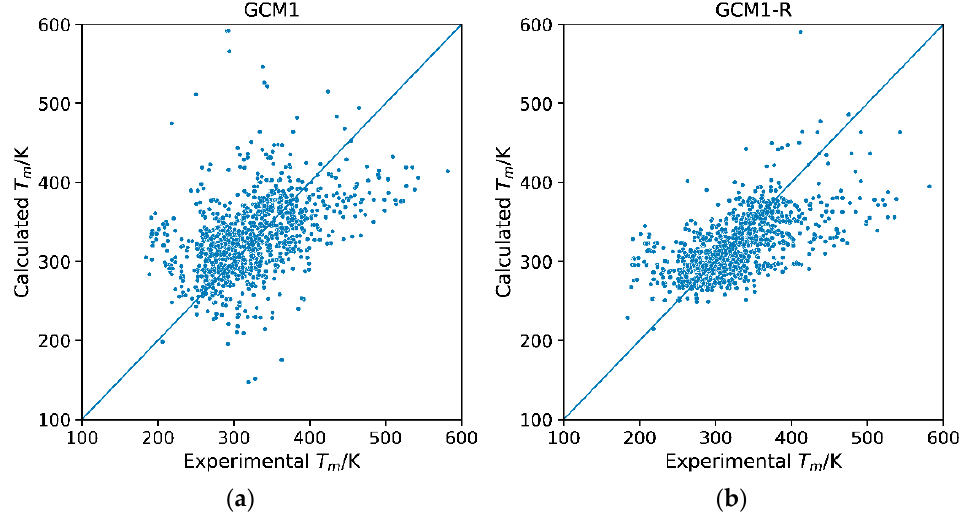
Figure 6. Parity plots of calculated versus experimental melting points for ( a ) GCM1 and ( b ) GCM1-R.